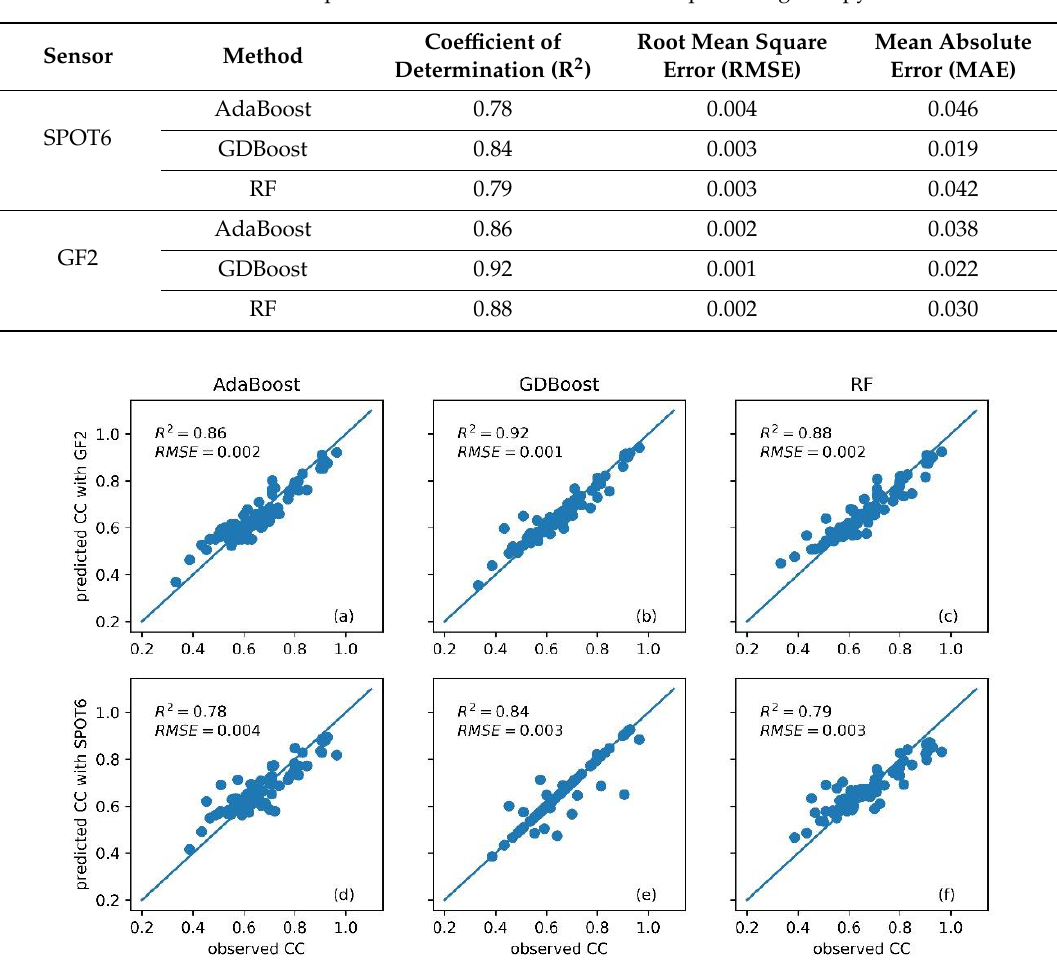
Figure 5. Observed vs. predicted canopy cover using SPOT6 and GF2 imagery with di ff erent regression models. The solid line indicates the 1:1 correlation between observed and predicted values. ( a ) results of the AdaBoost model in GF2 ( b ) results of the GDBoost model in GF2 ( c ) results of the RF model in GF2 ( d ) results of the AdaBoost model in SPOT6 ( e ) results of the GDBoost model in SPOT6 ( f ) results of the RF model in SPOT6. (CC represents canopy cover, AdaBoost represets Adaptive boosting method, GDBoost represents Gradient boosting model, and RF represents random forest. R 2 represents coe ffi cient of determination, RMSE means root mean square error.)